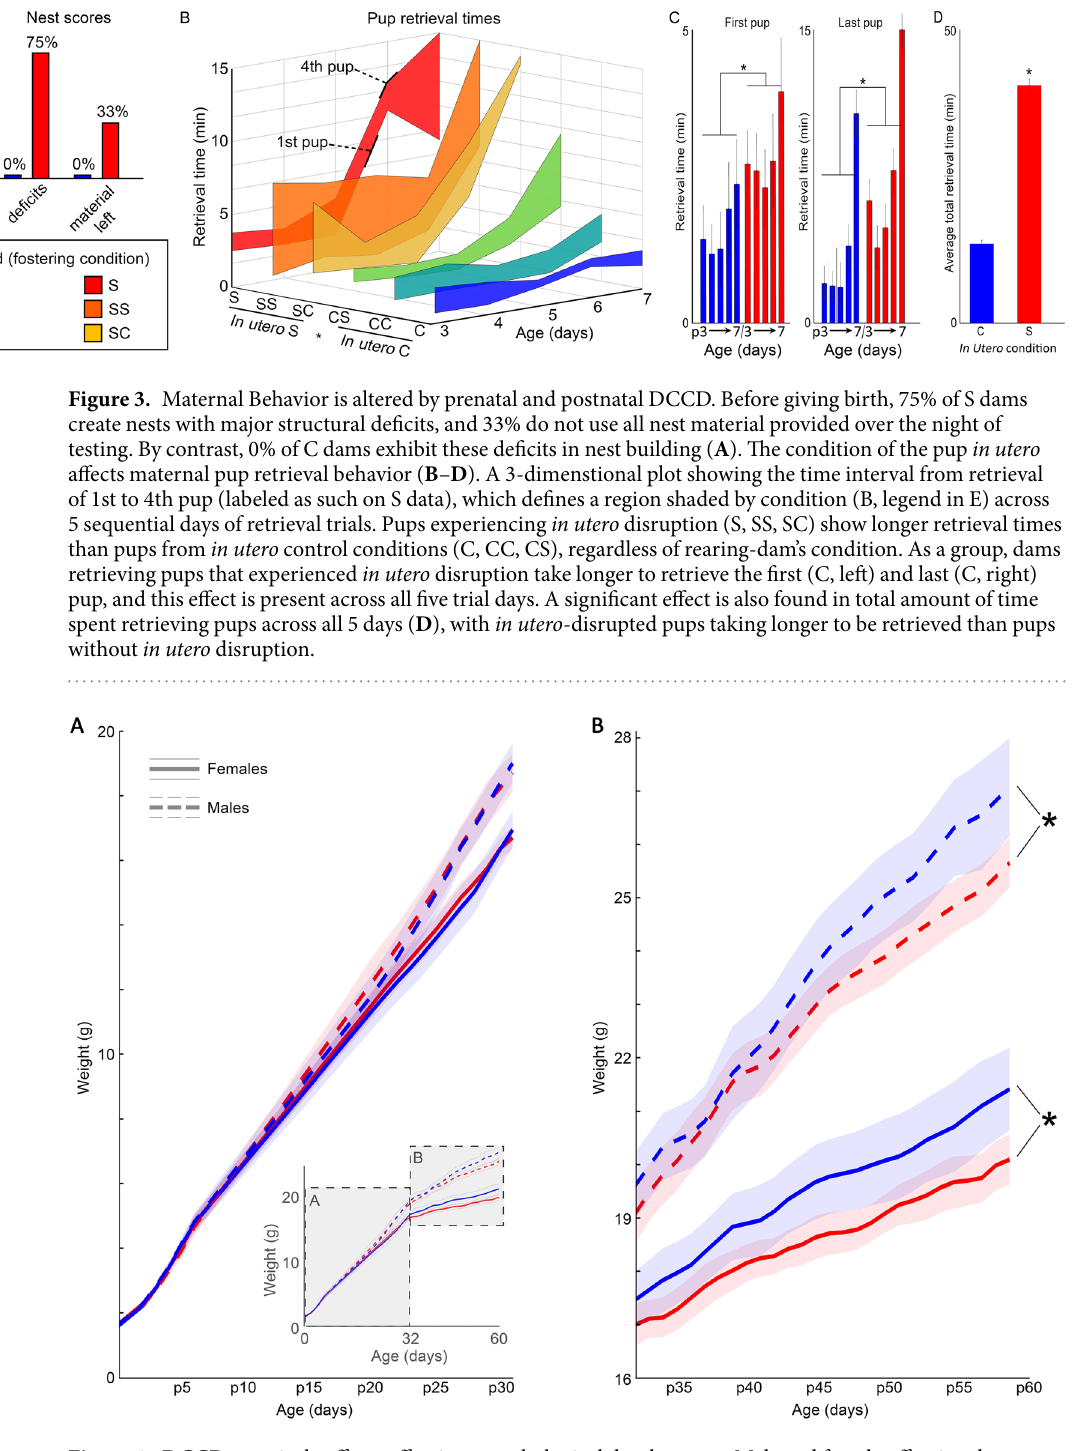
Figure 4. DCCD negatively affects offspring morphological development. Male and female offspring do not differ in body mass half-way through postnatal development ( A ), but by onset of adulthood (p60) S (red), offspring are significantly underweight in both males (dashed lines) and females (solid lines). Life-time growth curve show in (A,